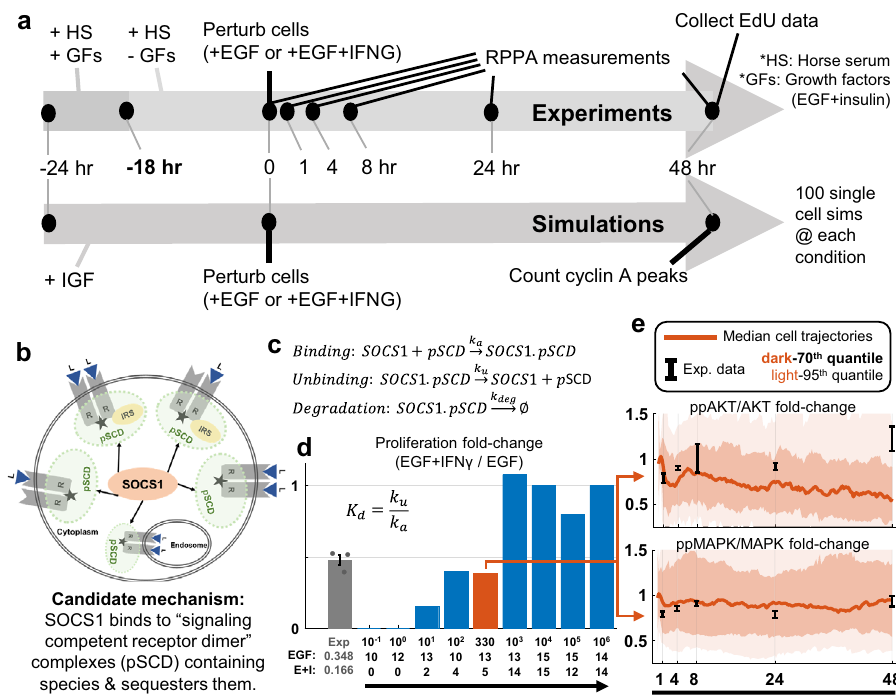
Fig. 5 SPARCED-I model suggests that a SOCS1-based sequestration mechanism can explain IFN γ -induced cell proliferation decreases. a Experimental setup and simulation work fl ow for SPARCED-I model variant analysis. See Methods. b Candidate mechanism schematic: SOCS1 sequesters activated ligand-receptor complexes. c The reactions show one set of examples added to capture the inhibitory mechanism. pSCD: activated ligand-receptor complexes. K d : Disassociation constant. d Simulation of 100 stochastic cells for SPARCED-I-SOCS1 model at different K d values (varied uniformly between − 1 and 6 in log10 scale) for SOCS1 binding (blue bars) showed that SOCS1 sequestration of activated receptor complexes can explain the IFN γ effect on cell proliferation inhibition, compared to experiments (gray bar). The number of cells in S-phase at 48 h of simulation time are shown on the x-axis ( fi rst row: K d values, second row: cells with EGF, third row: cells with EGF + IFN γ ). The y-axis is the ratio of number of cells in S-phase with IFN γ to without IFN γ . The experimental data (Exp.) are from three independent replicates (dots) and represent mean ± s.e.m. The mean of each experimental condition is given in x-axis. The orange bar is K d set at the estimated initial value (from GRB2-Receptor binding/unbinding reactions). e The K d value used for these trajectories corresponds to the orange bar in ( d ). Normalized ppAKT and ppMAPK levels show a signi fi cant decrease after IFN γ treatment, when EGF + IFN γ SPARCED-I-SOCS1 model simulations are compared to EGF alone case. RPPA data (synapse.org/LINCS_MCF10A) are shown in black, from three independent replicates (error bars are s.e.m.). Colored dark lines represent median cell trajectories from simulations, dark and light-colored regions represent 70th and 95th quantiles, respectively. Source data are provided in Source